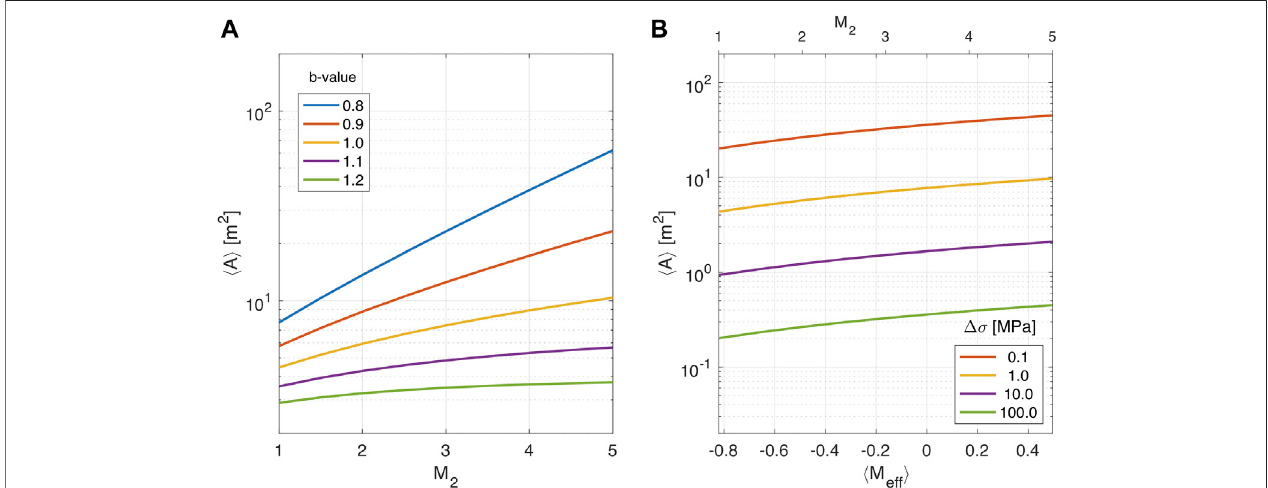
FIGURE 3 | Average rupture area 〈 A 〉 obtained by Eq. 6 for b -values 0.8, 0.9, 1.0, 1.1, 1.2 with stress drop 1 MPa in (A) and for stress drops 0.1, 1, 10, and 100 MPa with b (cid:1) 1 . 0 in (B) . The following constants were used: c (cid:1) 9 . 1 , d (cid:1) 1 . 5 and f (cid:1) 1. The plots were generated for minimum magnitude M 1 (cid:1) − 2 and maximum magnitude M 2 in the range from 1 to 5. The corresponding effective magnitude 〈 M eff 〉 on the horizontal axis in (B) was obtained by Eq. 4 . Both plots show nonlinear increase of 〈 A 〉 with the maximum magnitude M 2 .